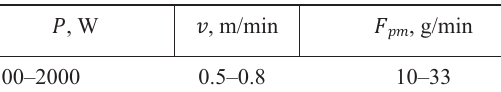
Table 1. Range of suitable laser cladding technological parameters for laser beam with spot size of 4